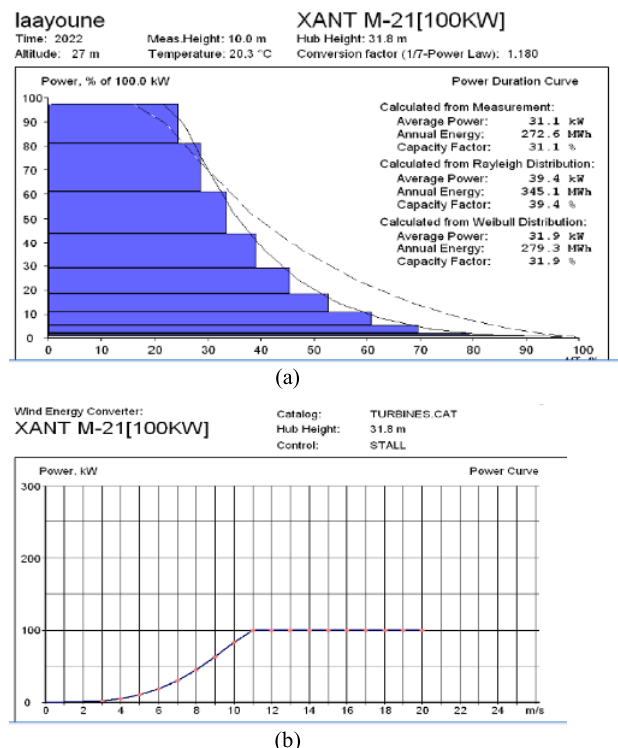
Fig. 6. (a) and (b) Annual production for the XANT M-21 turbine [100KW] calculated by